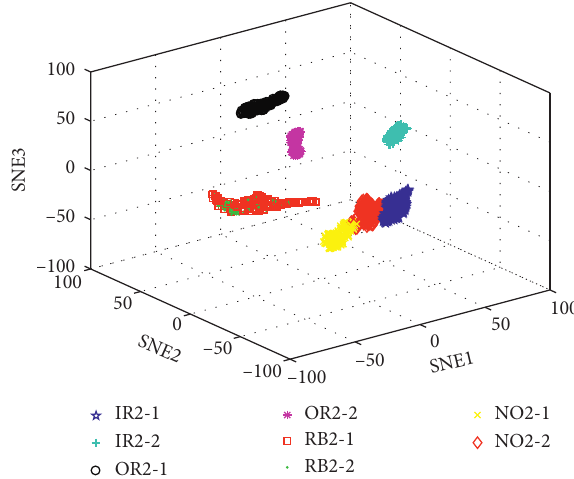
Figure 11: Diagnosis results of the 10 trials using the four methods.